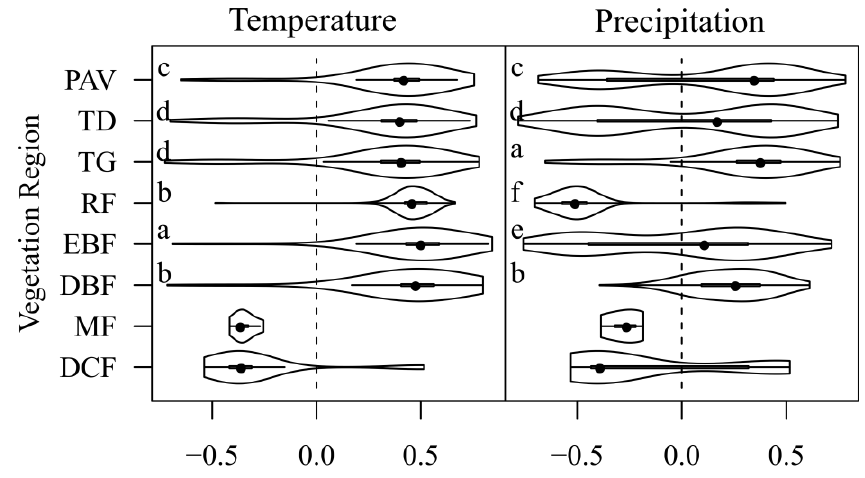
Figure 6. Violin plots of correlation coefficients between annual NDVI and temperature and precipitation at each pixel in each vegetation region. Grouping results of Games-Howell post hoc pairwise comparison analysis are labeled with letters at left. Regions with an insufficient number of pixels (<100) with significant correlations are excluded from post hoc tests. Vegetation regions with the same letters have insignificant differences in correlations. Average correlations from positive to negative are labeled in alphabetical